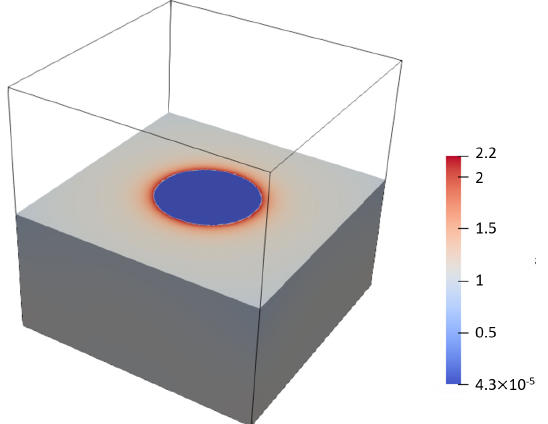
Figure 21. Two-dimensional view (xy-plane) of quadrature points in the domain obtained using kd-tree cell division. A control point grid of 30 × 30 × 30 was used.